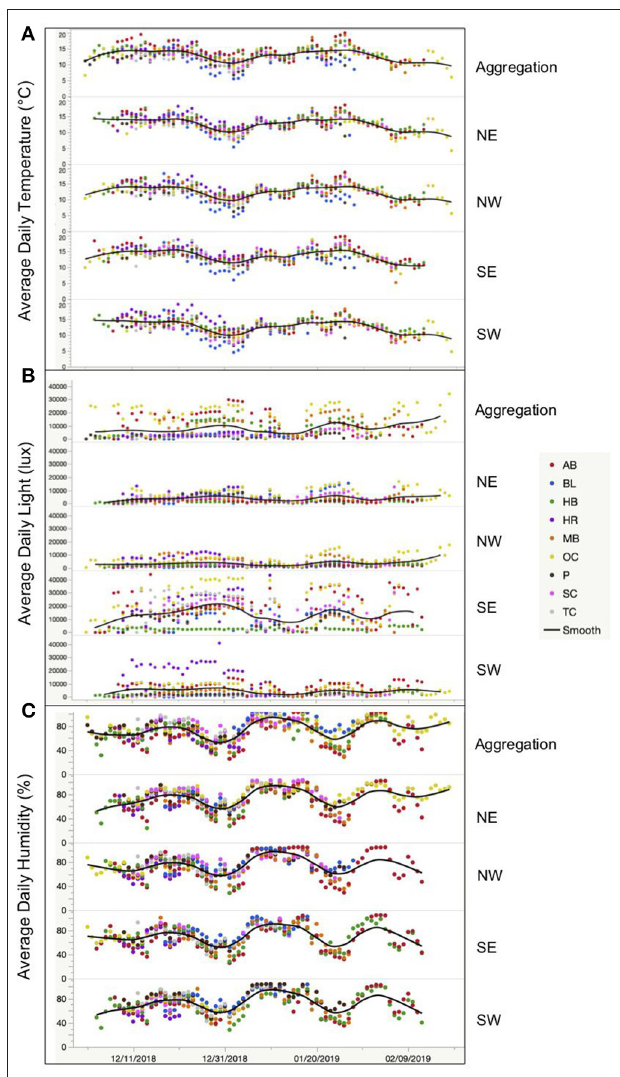
FIGURE 9 | Climate data for each sample location across the groves in December and January of the 2018–2019 overwintering season for (A) average daily temperature ( ◦ C), (B) average daily light intensity (lux), and (C) average daily humidity (%). When testing for uniformity across the groves in each sample location, we find that the aggregation does not show less variation for any of the climatic variables across the groves than the other sample locations. Less variation would be visualized as a flatter less variable line. Site names are as in Figure 8 and are